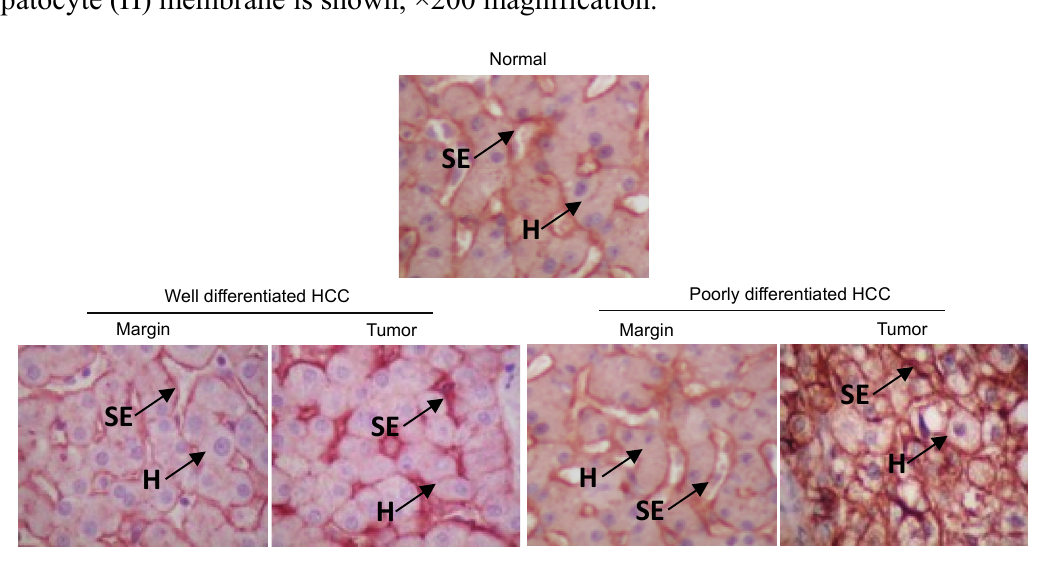
Figure 7. CD81 expression is associated with tumour differentiation status. Representative immunohistochemical staining of CD81 (2s131, 5 µg/mL) in normal liver, peri-tumoral tissue and hepatocellular carcinoma (HCC) tumor tissue with well and poorly differentiated HCC (n = 5 in each category). CD81 expression on the sinusoidal endothelium (SE) or hepatocyte (H) membrane is shown, ×200